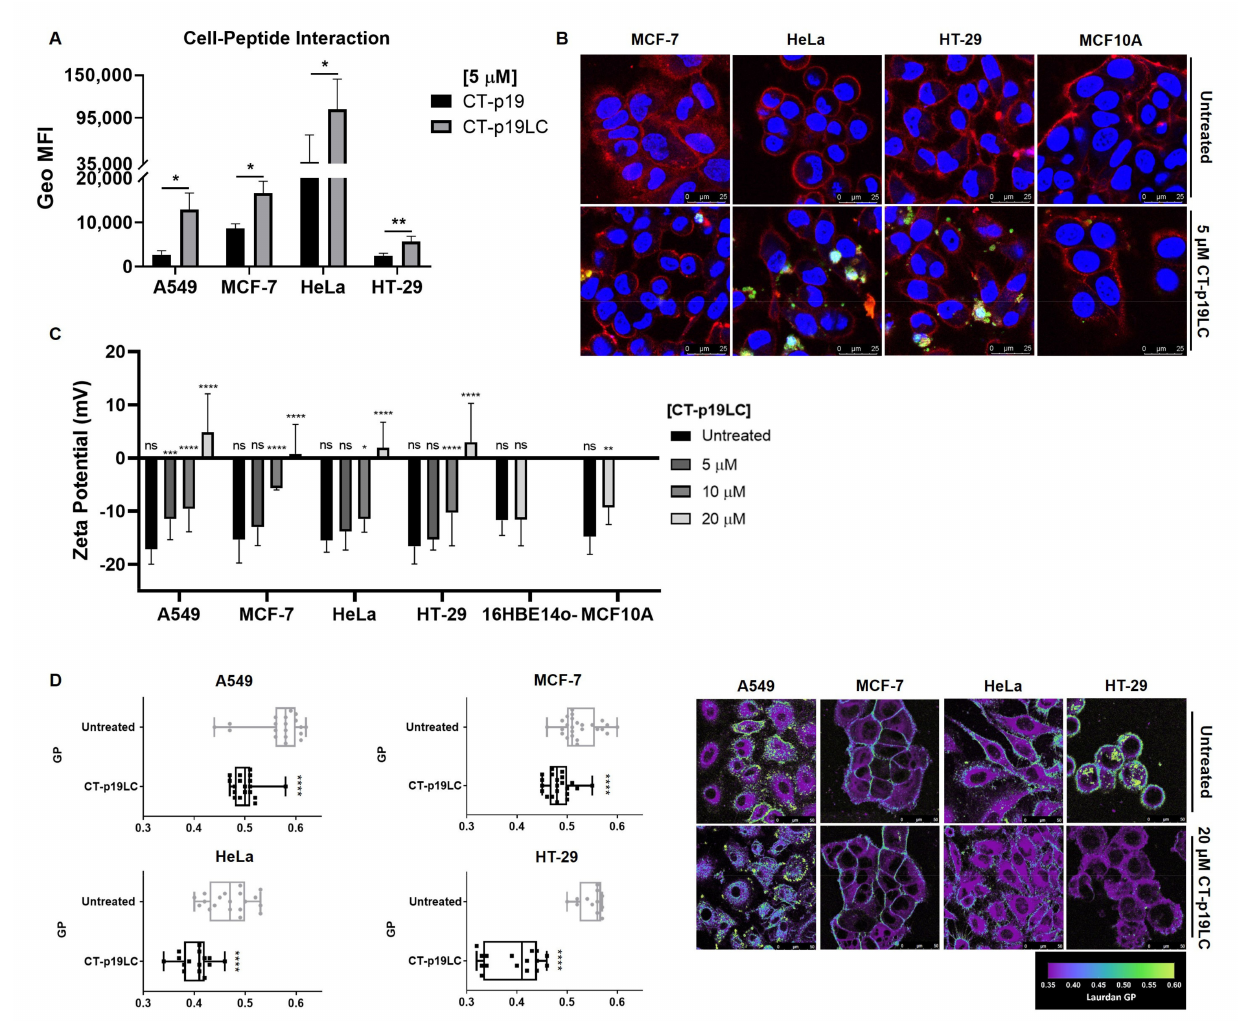
Figure 4. CT-p19LC membrane-active properties: ( A ) flow cytometry quantitative analysis of cancer cell–peptides interac- tion. Results are reported as the means ± SD, and each condition had at least n = 3. * and ** denote significant differences of p < 0.1 and p < 0.01, respectively, when comparing CT-p19LC treatment with CT-p19 treatment; ( B ) representative confocal microscopy qualitative analysis of CT-p19LC cellular uptake by MCF-7, HeLa and HT-29 cancer cells and MCF10A non-cancer cells incubated with PBS pH 7.4 as control and 5 µ M of peptide labeled with 5,6-FAM (green color) for 2 h. WGA Alexa Fluor ® 633 and Hoechst 33342, for staining the plasma membrane and nucleus, respectively, are shown in red and blue colors. Scale bars represent 25 µ m; ( C ) zeta potential of A549, MCF-7, HeLa and HT-29 cancer cells and 16HBE14o- and MCF10A non-cancer cells in the presence of CT-p19LC peptide. A total of 1.5 × 10 5 cells/mL were incubated and stabilized for 30 min at 37 ◦ C with different peptide concentrations, and the zeta potential was measured. Data are represented as means ± SD. *, **, ***, **** and ns denote significant differences of p < 0.1, p < 0.01, p < 0.001 and p < 0.0001 and differences that were not statistically significant, respectively, when comparing the untreated condition (0 µ M) with increasing concentrations of CT-p19LC (5, 10 and 20 µ M); ( D ) the effects of CT-p19LC on the cell‘s membrane order for A549, MCF-7, HT-29 and HeLa cancer cell lines and their respective GP values. All represented cell lines were seeded on µ -Slide 8-well glass-bottom chambers and treated with 20 µ M of CT-p19LC for 2 h. For each condition, 5 µ M of Laurdan was used. Untreated cells were used as the control. Homemade software built in a MATLAB environment was used to measure the GP values. Representative Laurdan GP images are shown. Scale bars represent 50 µ m. Average GP values are expressed as means ± SD from at least 15 individual cells in each condition. Results are compared to the untreated population with equal variance (****, p <